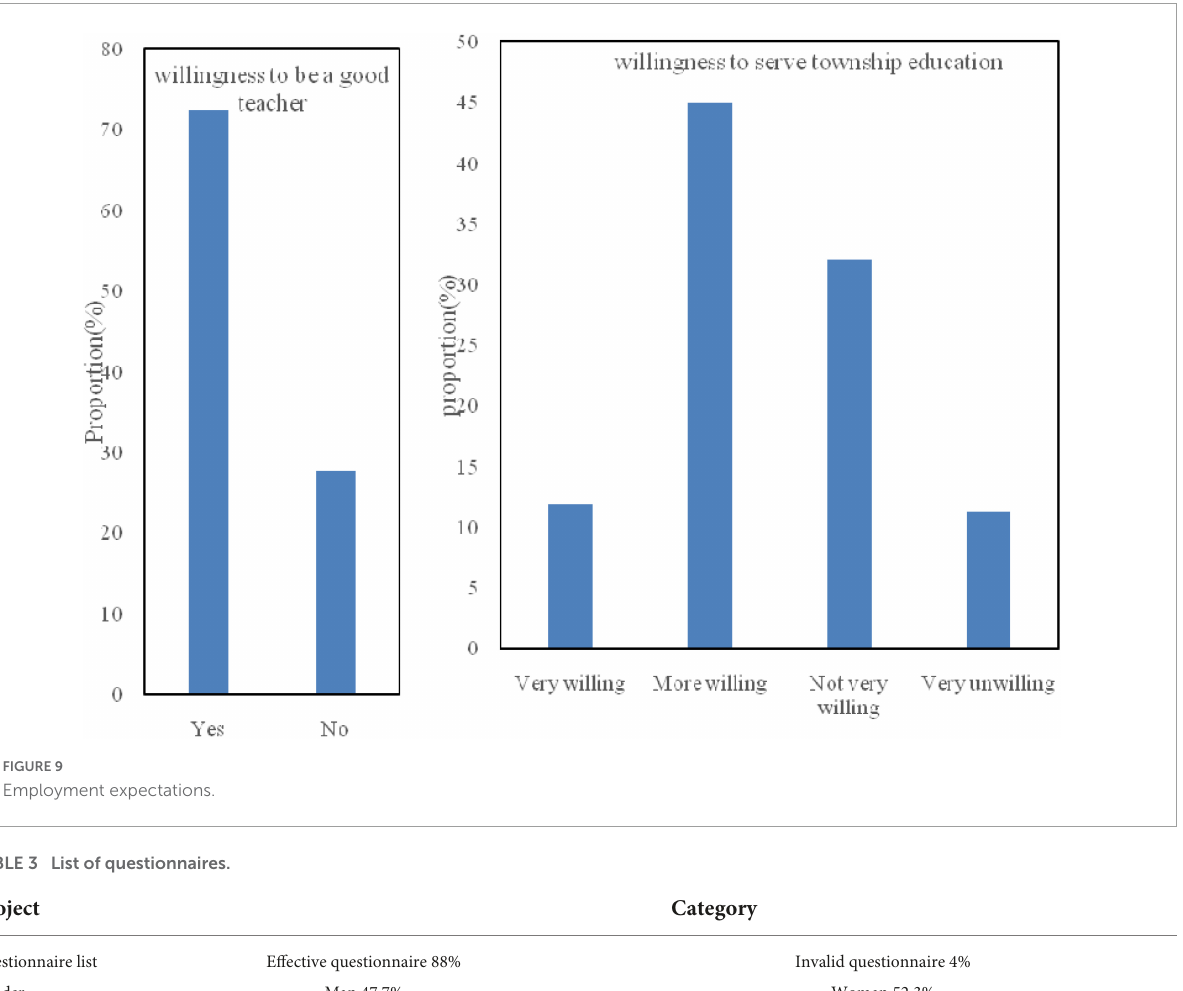
TABLE 3 List of